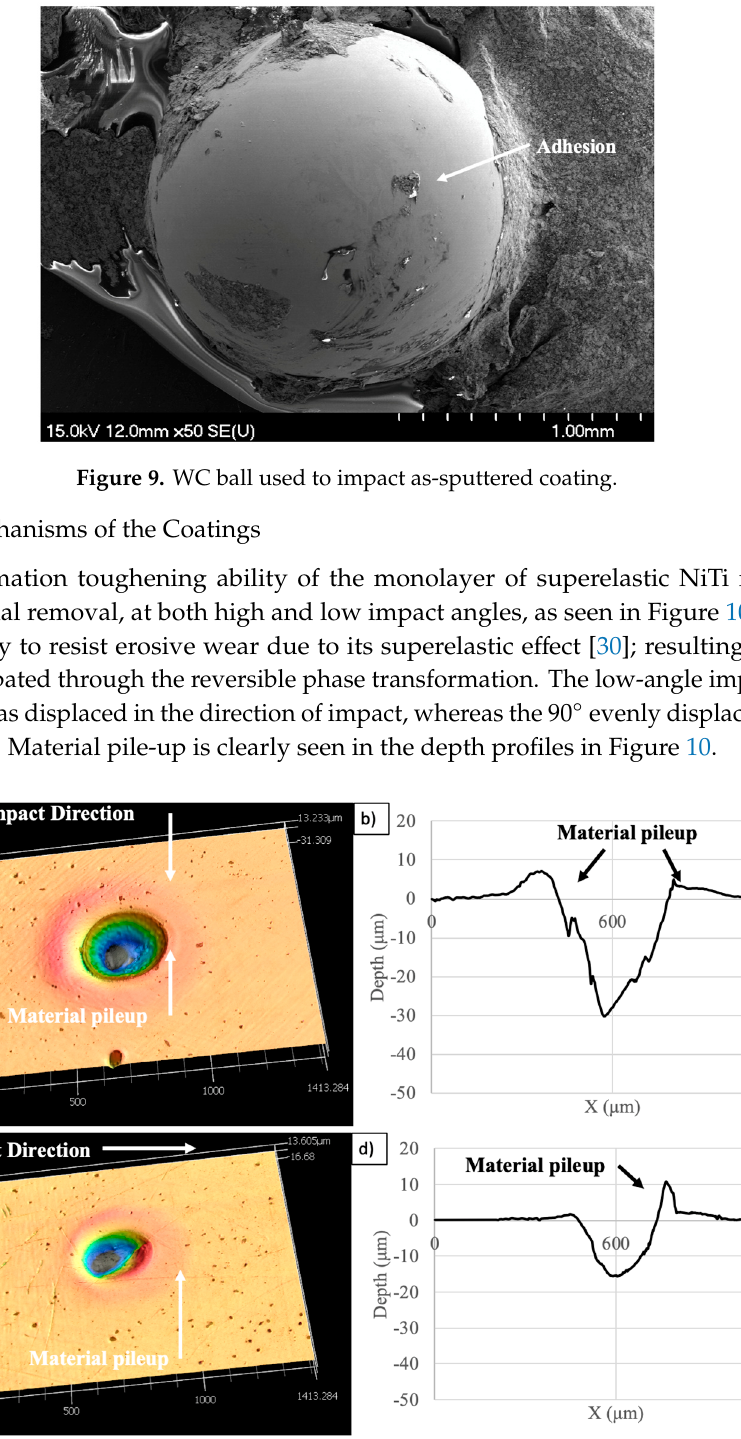
Figure 8. Single particle 30-degree impact a ) as-sputtered b ) 650 °C nanolaminate c ) superelastic NiTi coatings.